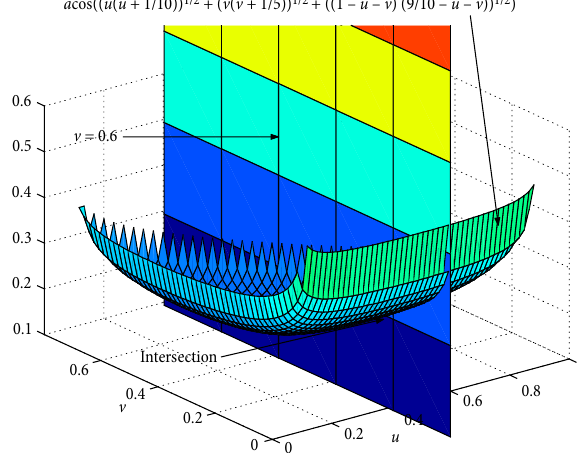
Fig. 3. The intersection between d ( u , v ) and v =